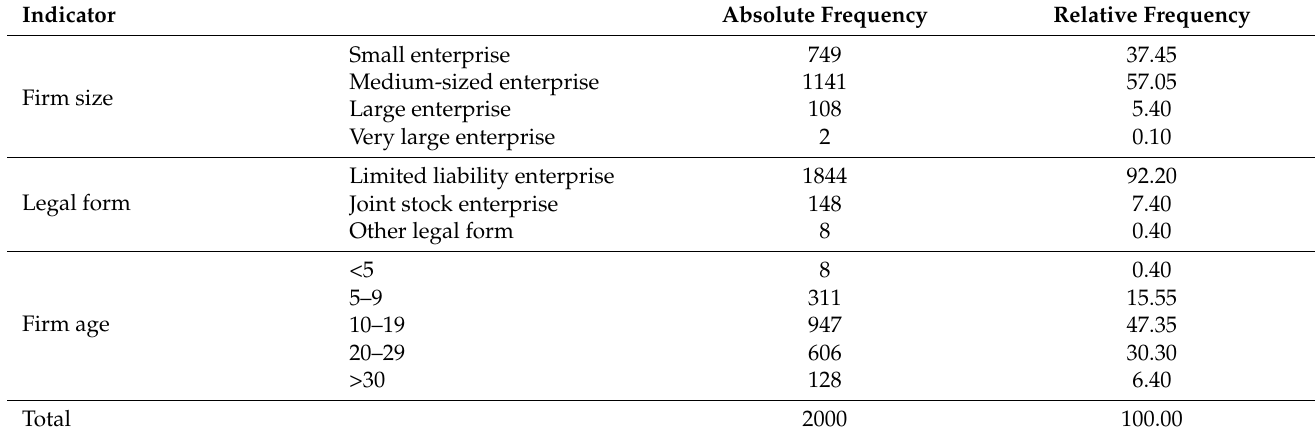
Table 1. The elementary data of the enterprises operating in the construction sector in the period under the review.